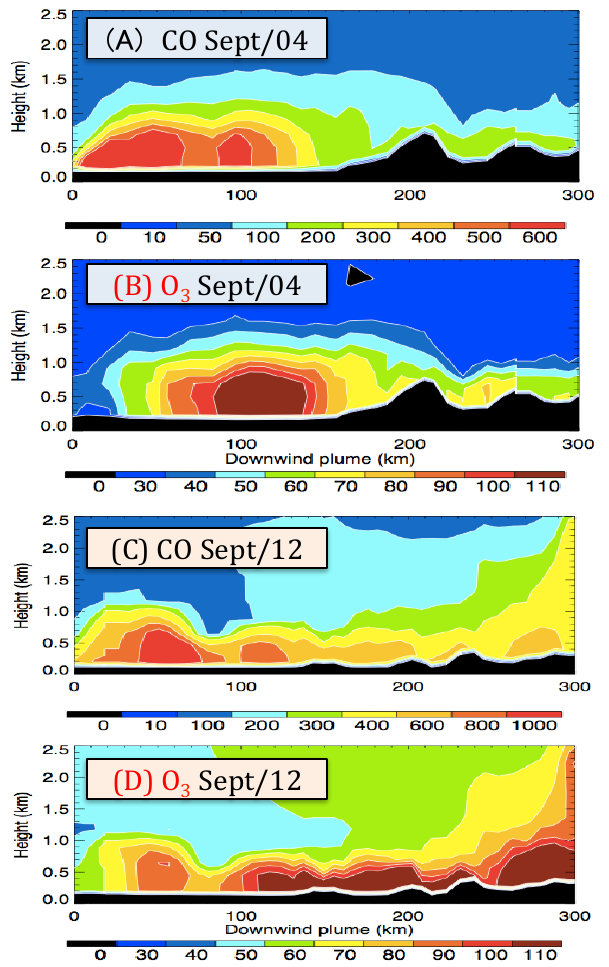
Fig. 9. The calculated cross section (altitude–downwind distances) of the city plumes of CO and O 3 on 4 September (clean period) and 12 September (polluted period), respectively.